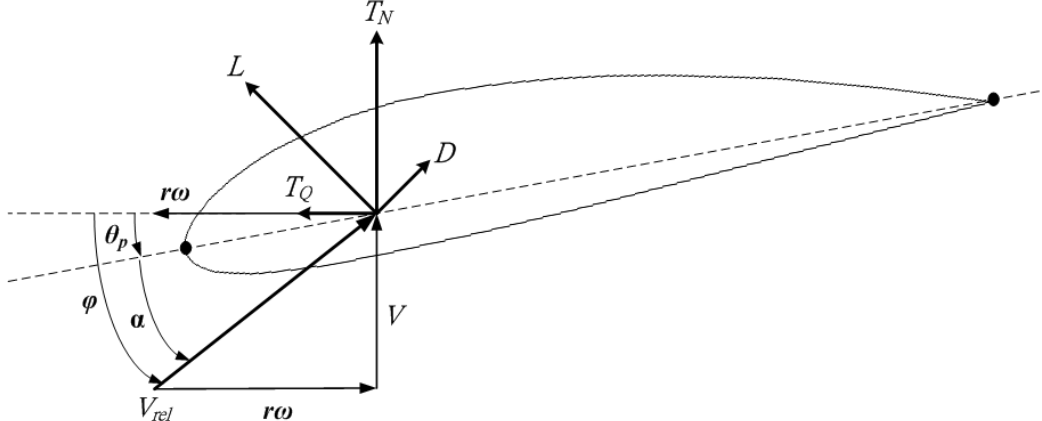
Figure 1. Diagram of angles and forces on one of the blade